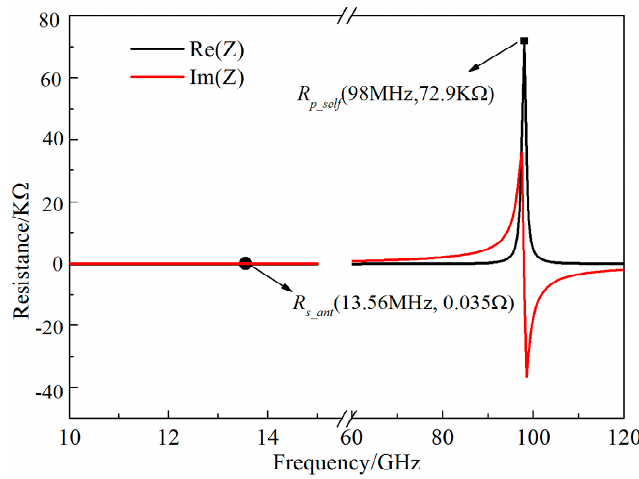
Figure 7. The real and imaginary part of Z parameter.